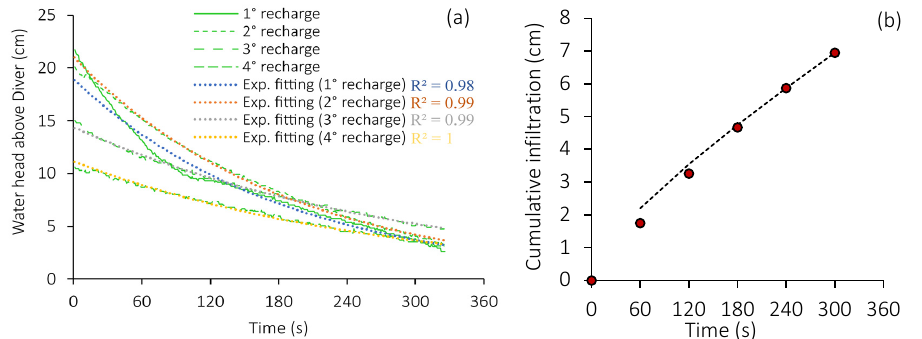
Figure 10. ( a ) Water head above diver measured within the inner ring for the four consecutive recharge simulations, fitted by exponential curves with related Pearson’s determination coefficients (R 2 ); ( b ) cumulative infiltration vs. time for the 4° recharge (the red markers show the measured data, the dashed line shows the model result of Philip [80].